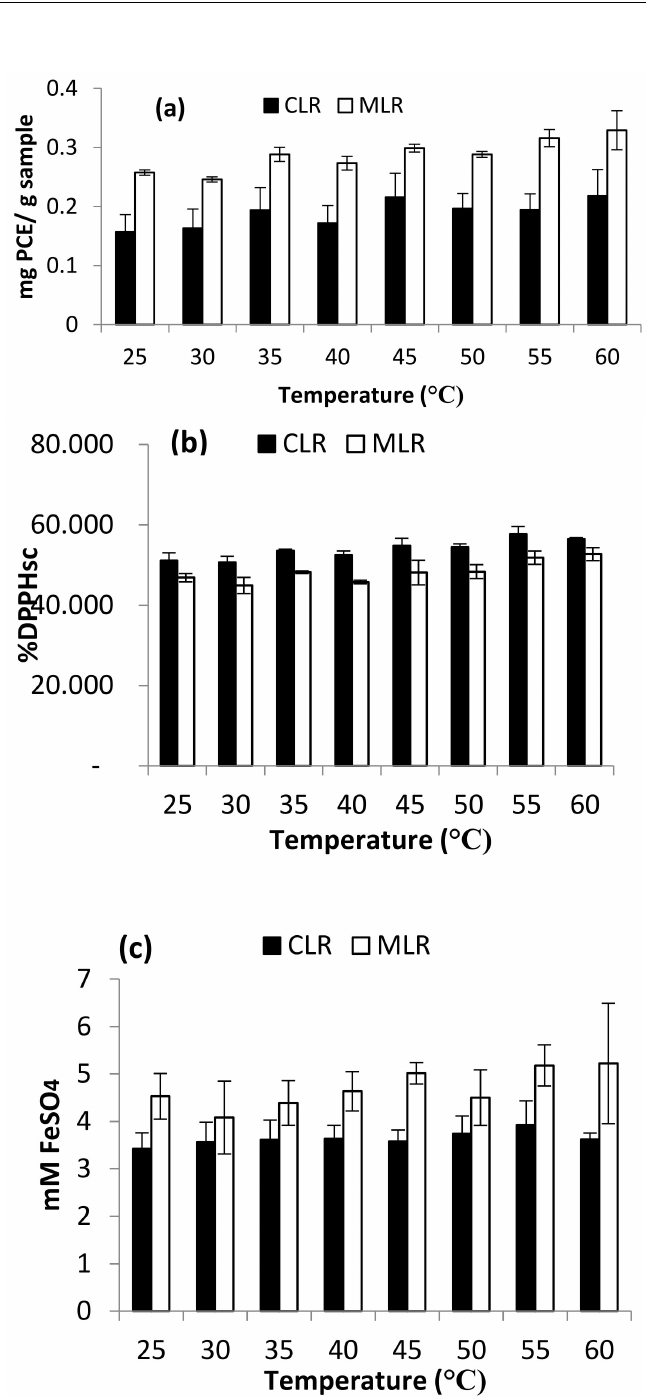
Figure 7. Effect of temperature on ( a ) Total flavonoid content ( b ) DPPH scavenging activity and ( c ) ferric-reducing antioxidant power